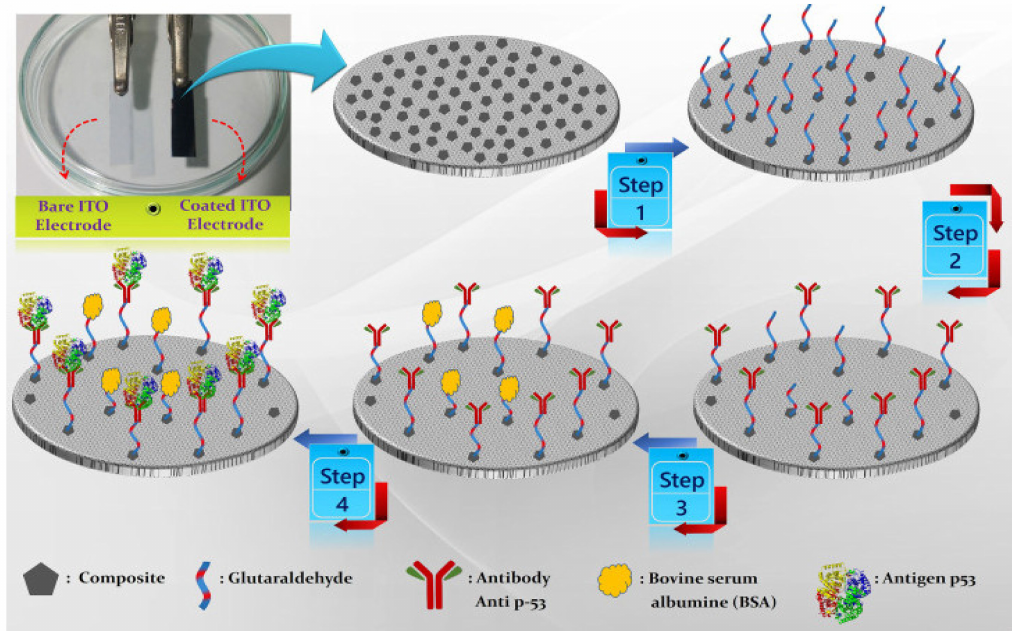
Figure 7. The schematic representation of chitosan and carbon black composite based electrochemical immunosensor. Step 1: modification of electrode with glutaraldehyde; step 2: immobilization of antibody; step 3: blocking with BSA; step 4: antigen capturing. Reprinted with permission from [69], published by Elsevier,